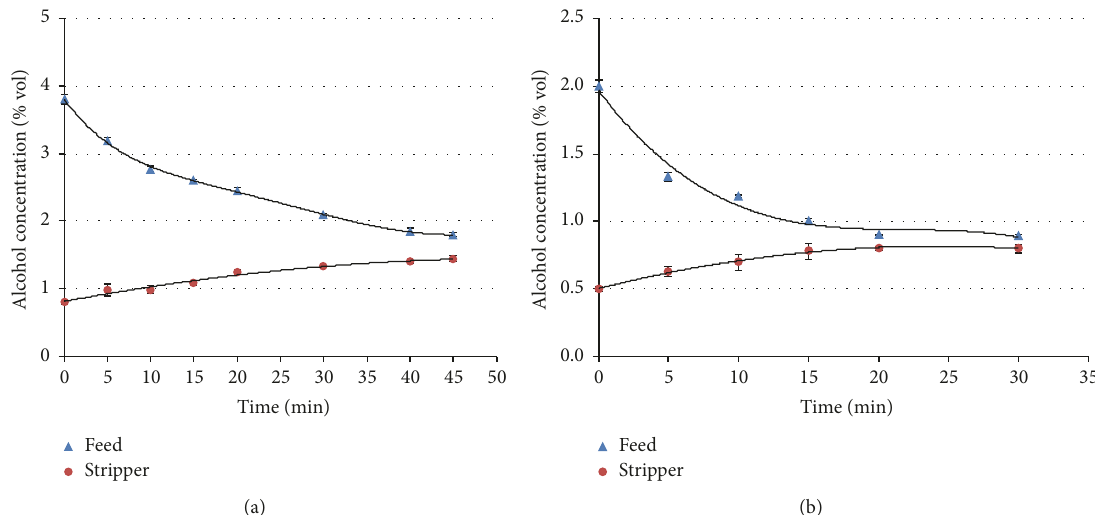
Figure 1: Dealcoholization kinetic of hydroalcoholic solutions: (a) feed and stripper at 3.8 and 0.8 % vol, respectively; (b) feed and stripper at 2 and 0.5 % vol, respectively.